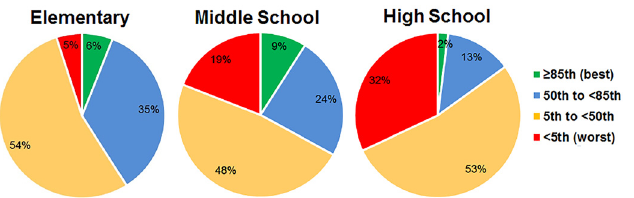
Fig 2. Aerobic Fitness Results from The President ’ s Challenge 1-mile Endurance Run. Performance level national standards were used to classify fitness of urban school students. Percentage of the population at each grade level (elementary, middle, and high school) is shown. The 85 th and 50 th percentiles are benchmarks for Presidential awards.